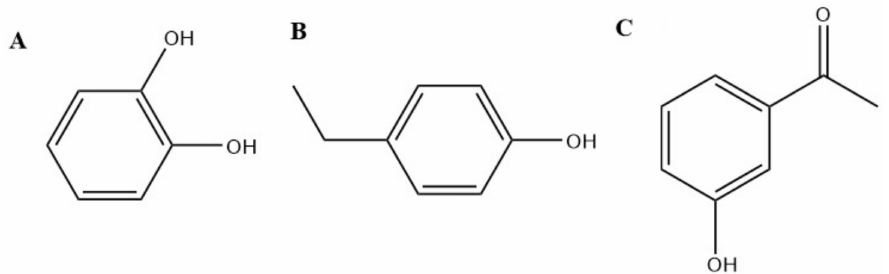
Figure 1. Chemical structures of ( A ) catechol, ( B ) 4-ethylphenol and ( C )